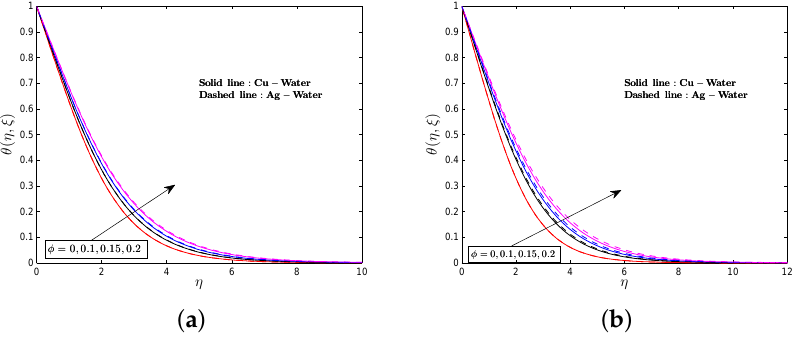
Figure 9. Temperature profiles for various values φ . ( a ) vertical plate; ( b ) horizontal plate.